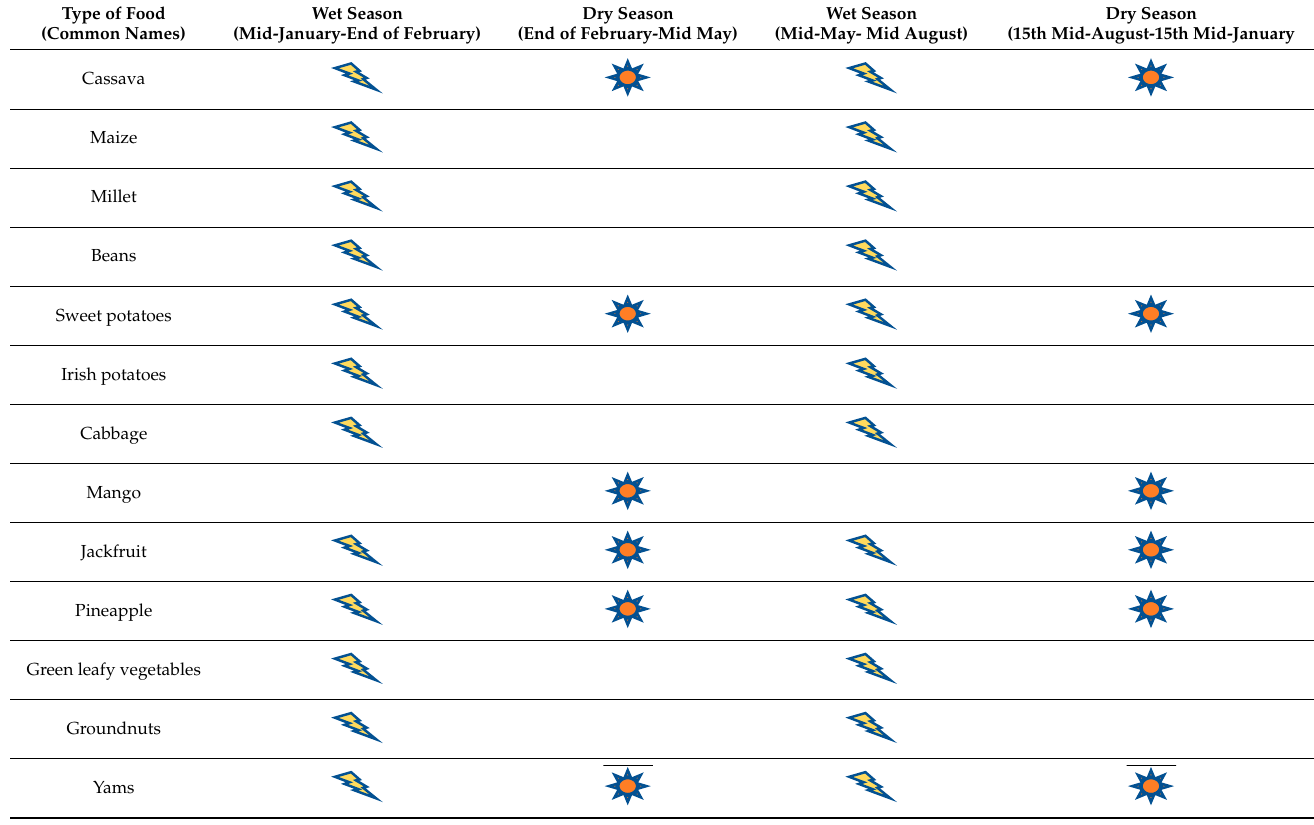
Lightening (wet season) and sun (dry season) icons indicate when the food items are harvested and eaten.